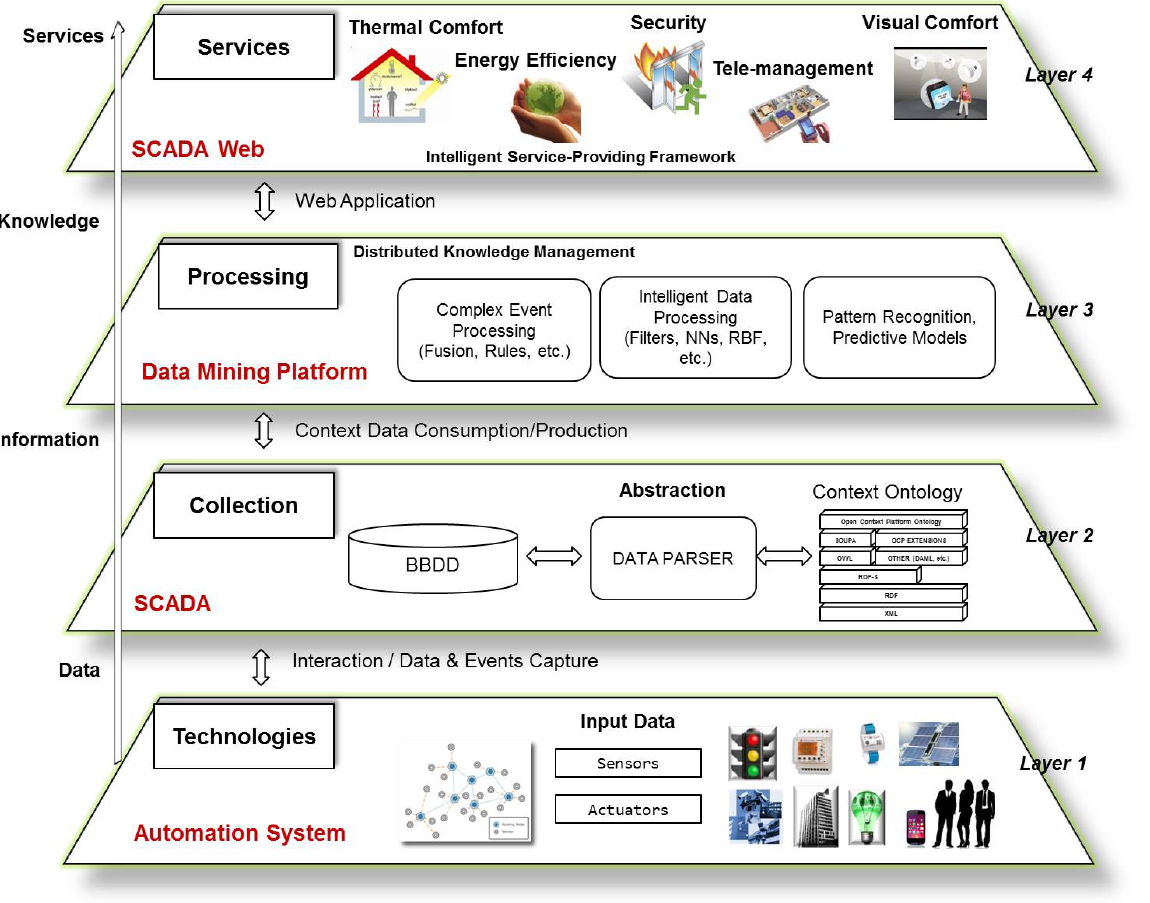
Figure 1. Layers of the base architecture of our smart building management